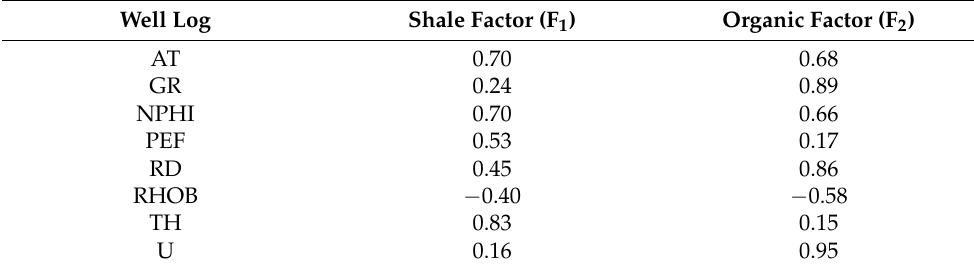
Table 5. Factor loadings rotated using the varimax algorithm for Well C. Well Log